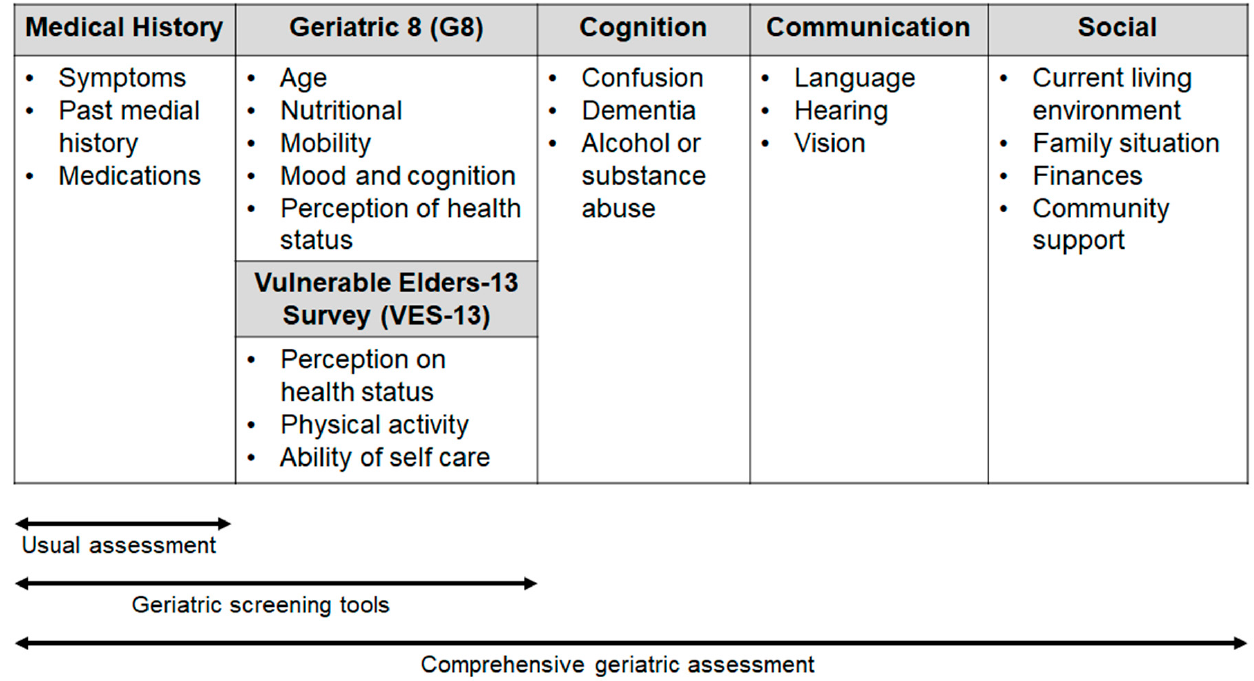
Figure 1. Areas of investigation used in the geriatric scales and assessment.